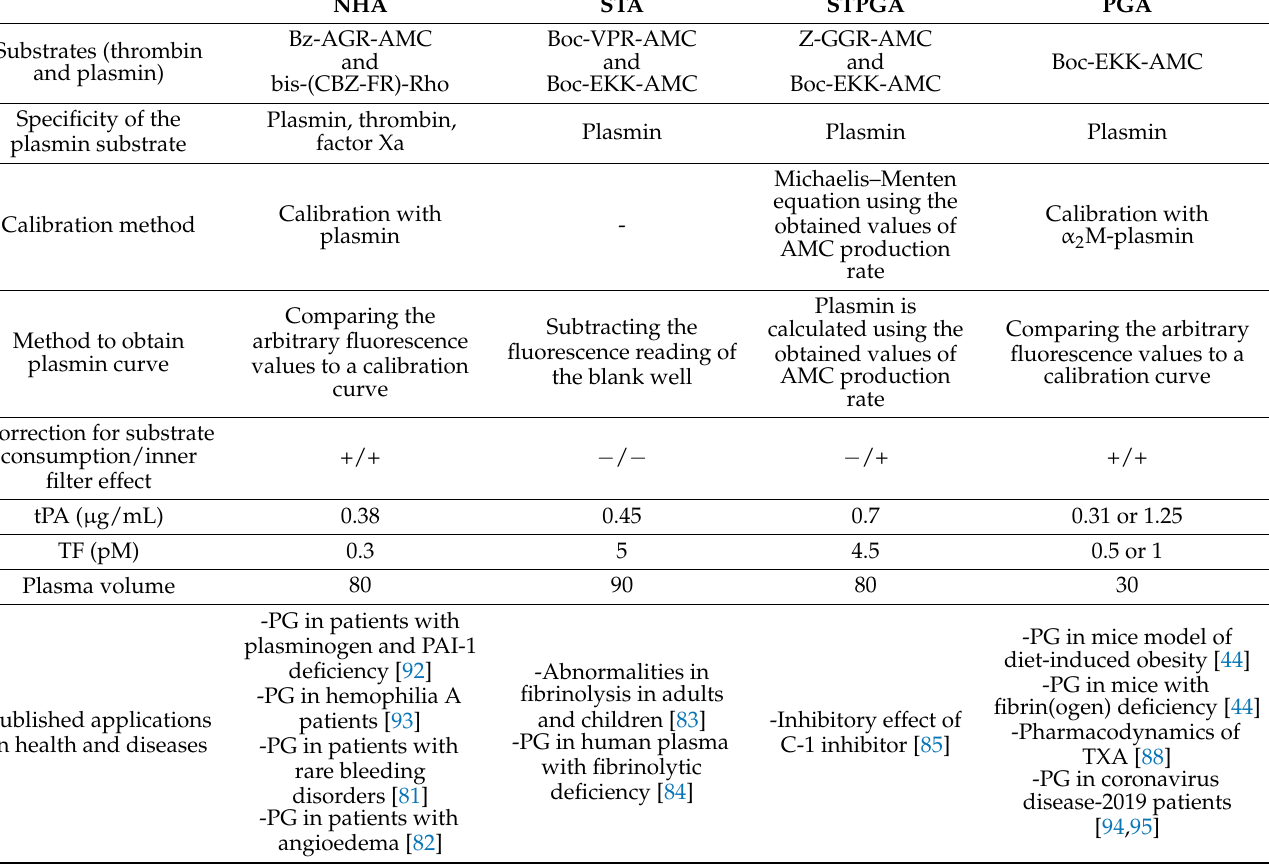
Table 2. Overview of the existing plasmin generation assays and their major properties and